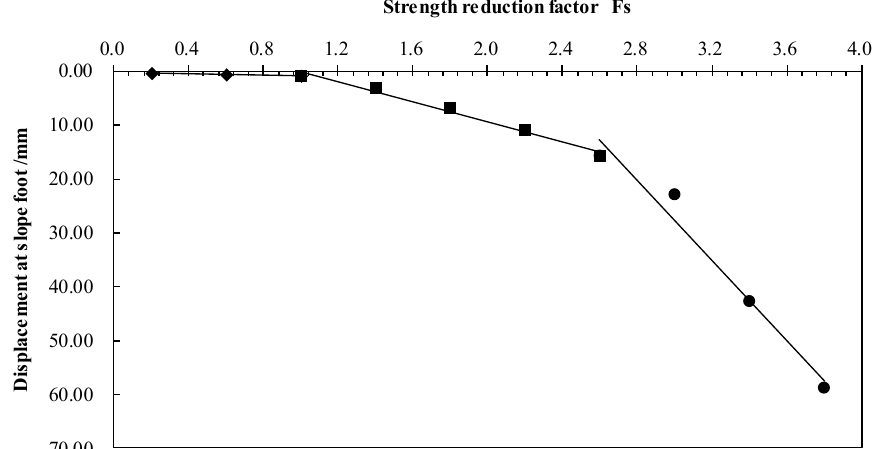
Figure 3. The relationship between the displacement of slope foot without prestressed anchor cables and the strength reduction factor.